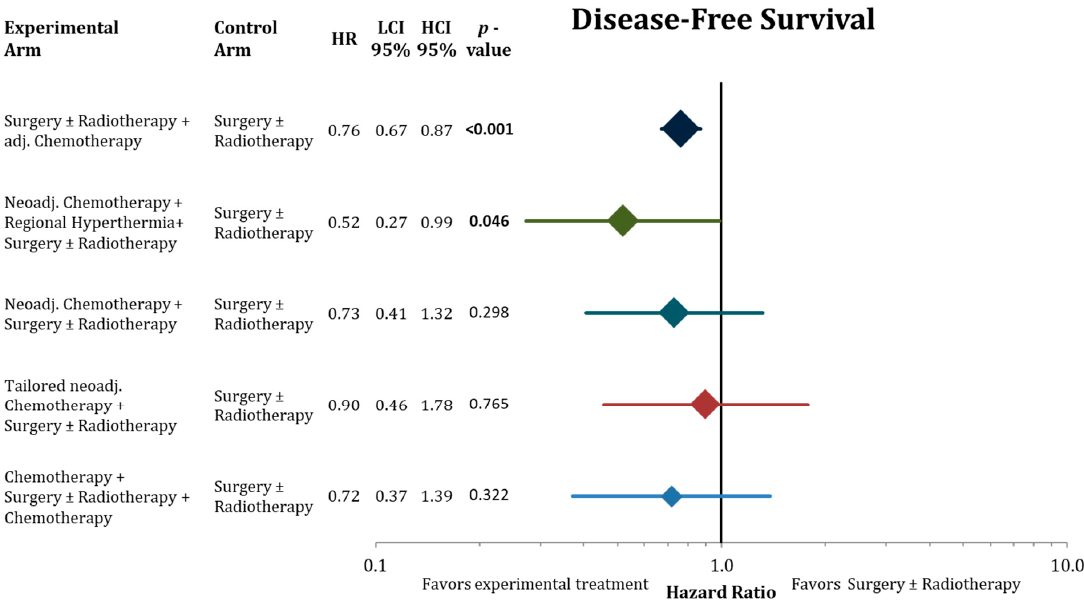
Figure 3. Forest plot comparing overall survival in the network analysis of the experimental treatments against surgery ± radiation therapy. Hazard ratios with the 95% confidence intervals and the corresponding p -values are presented. The size of the diamonds are proportional to the weights in the meta-analysis. HR = hazard ratio, LCI = lower limit of 95% confidence interval, and HCI = higher limit of 95% confidence interval. Bold values signify statistically significant values. Figures 4–6 illustrate the results of the network meta-analysis for the endpoints disease-free survival, local relapse-free interval, and distant relapse-free interval, respectively.